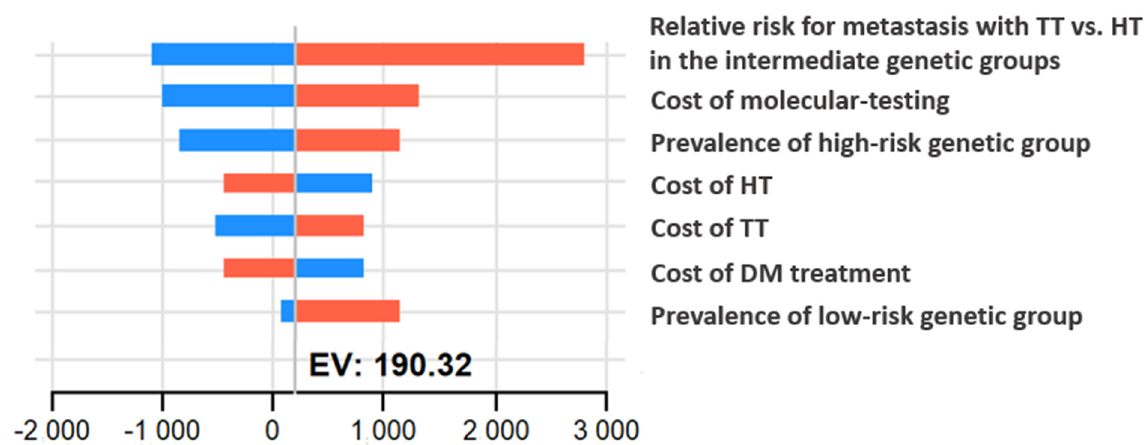
Figure 2. Tornado diagram presenting one-way sensitivity analysis of incremental cost effectiveness of GT over wGT. The vertical line represents the ICER using base-case values. Color coding repre- sents the range of each variable from low values (blue) to high values (red). This demonstrates the effect of possible variation in the variable value on the ICER: increasing values are indicated by red bars, while the effect of decreasing is indicated by blue bars. Prices are in USD. TT: total thyroidec- tomy; HT: hemithyroidectomy; DM: distant metastasis; ICER: incremental cost effectiveness ratio; EV: expected value.